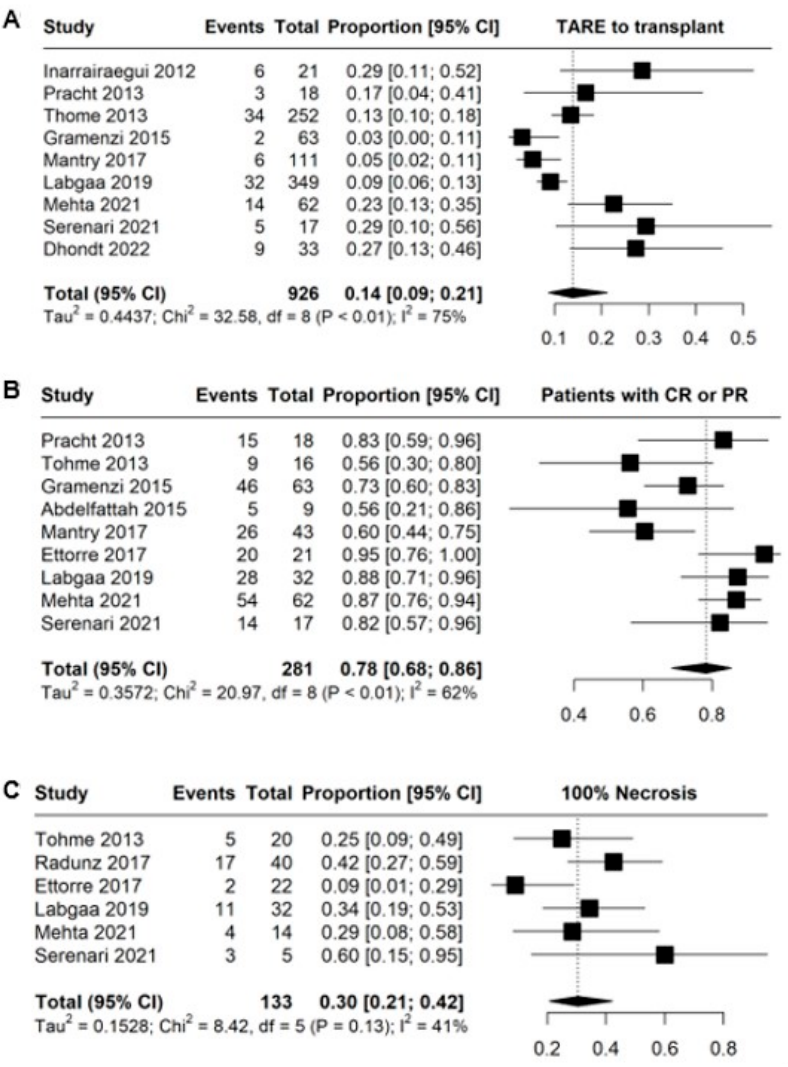
Figure 3. Results of pooled single-arm analyses. ( A ) Proportion of patients proceeding to transplant; ( B ) proportion of patients with either complete or partial response of the tumor; ( C ) proportion of patients with 100% tumor necrosis on histological assessment.